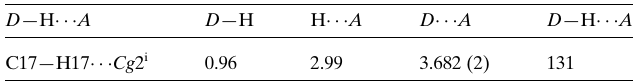
Table 1 Hydrogen-bond geometry (A˚ , (cid:3) ).